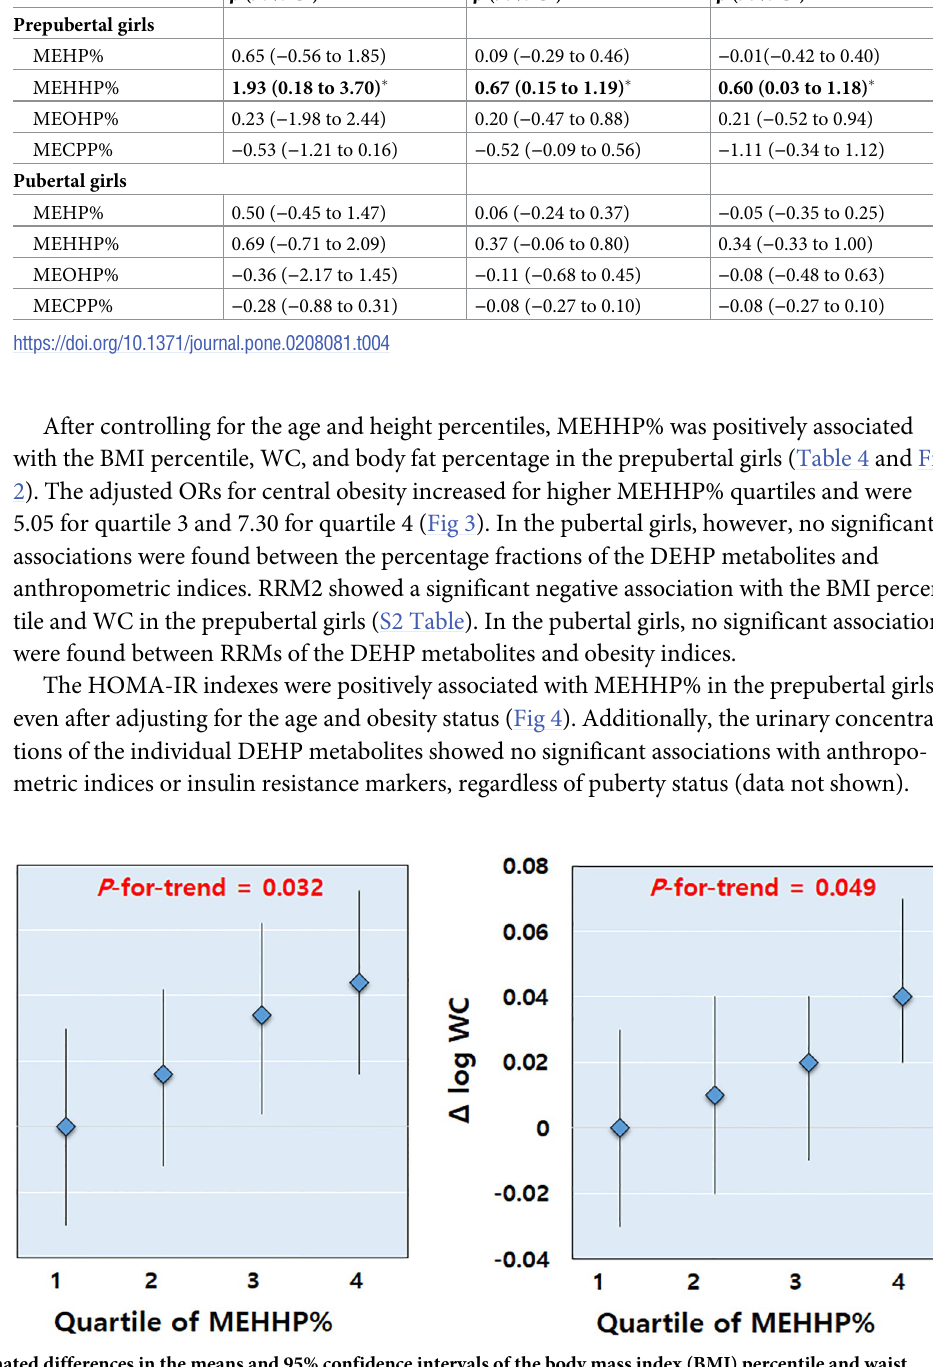
Fig 2. Estimated differences in the means and 95% confidence intervals of the body mass index (BMI) percentile and waist circumference (WC) stratified by the percentage fraction of mono(2-ethyl-5-hydroxyhexyl) phthalate (MEHHP%) quartiles in prepubertal girls (adjusted for age and height percentiles). For higher MEHHP% quartiles, the BMI percentile and WC increased in prepubertal girls ( P -for-trend <